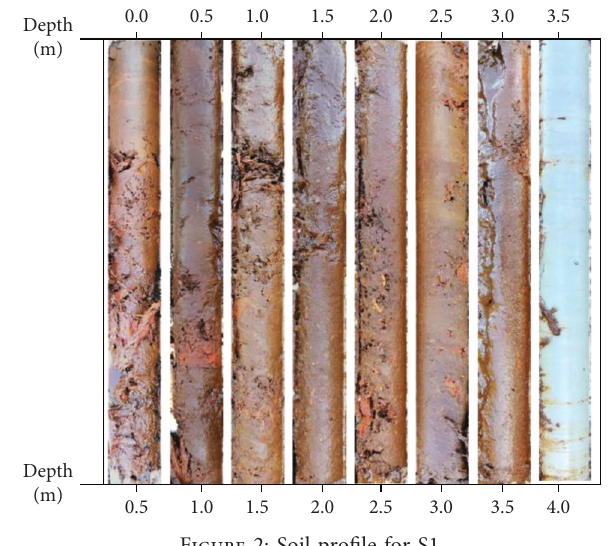
Figure 2: Soil profile for